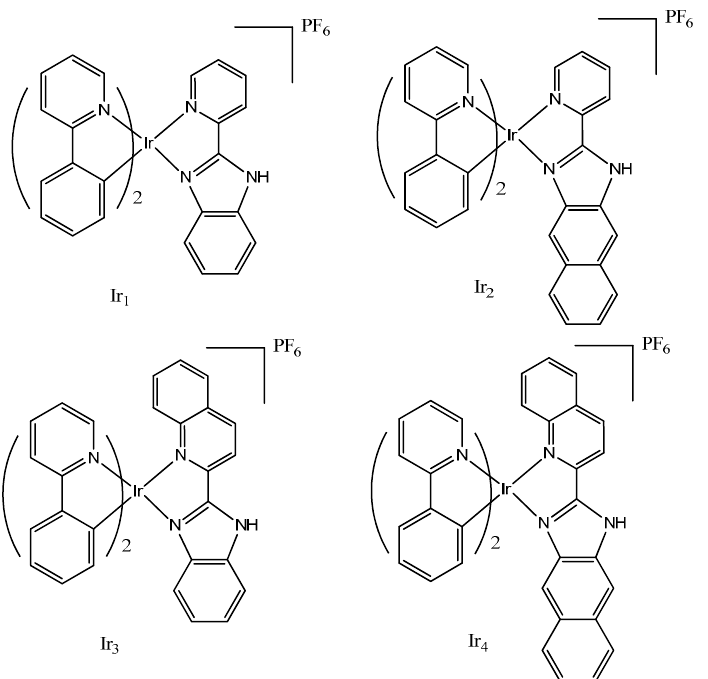
Figure 5. Chemical structures of complexes Ir 1 –Ir 4 . Adapted from [55] with permission from the journal ACS Appl. Mater. Interfaces , Copyright 2017 American Chemical Society.